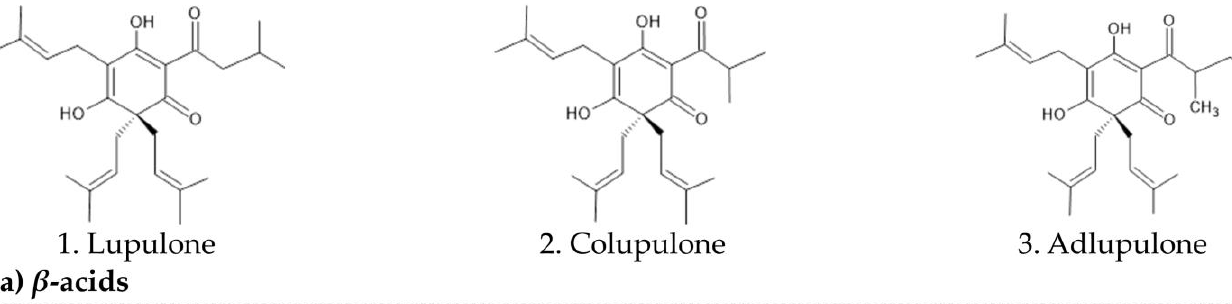
Figure 1. Chemical structures of tested compounds from hops on chikungunya virus strain: ( a ) β - acids, ( b ) α -acids and ( c ) xanthohumol. 2. Results In order to achieve an efficient liquid/liquid separation by CCS with high resolution of constituents of the supercritical hops extract, several solvent systems were evaluated on a small scale in test tubes. A solvent system is considered suitable when K values of the constituents to be isolated range in the area of 0.5 – 2 [22,23]. K values are expressed as the ratio of the concentration of an analyte in the stationary phase to its concentration in the mobile phase. Finally, after the solvent search, the solvent system consisting of hep- tane-ethyl acetate-ethanol-NH 4 Ac buffer (1.0 M) at 7:3:5:5 ( v / v ) was selected as most con- venient and used in the separation process. After CCS was run, five fractions were re- tained and chosen, keeping some diversity in the ratio of the congeners from α - and β - phloroglucinols, besides one fraction consisting of cohumulone (major α -acid) and one enriched on the major chalcone xanthohumol. All compounds were identified after UHPLC-MS/MS (data not published) analysis and fitted retention time after HPLC anal- ysis [24]. The fraction of cohumulone was analyzed by NMR 1 H and 2D experiments and the confirmation of structure was made by comparing with literature data [18]. The frac- tions and respective compounds kept proceeding to the in vitro tests were defined as fol- lows: •